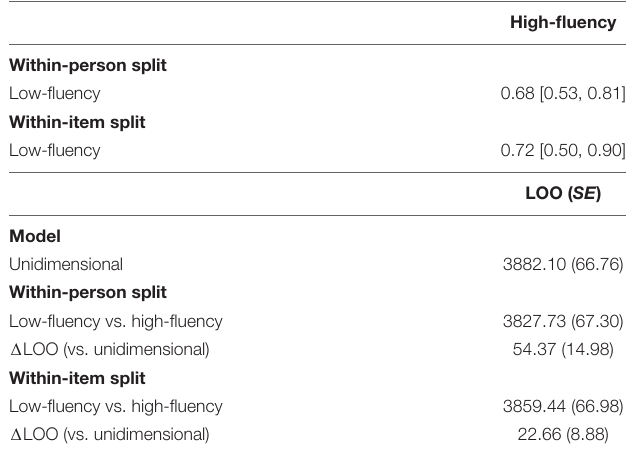
TABLE 3 | Correlations of latent variables and model comparison results for a differentiation of low-fluency and high-fluency creative quality for be-creative instructions